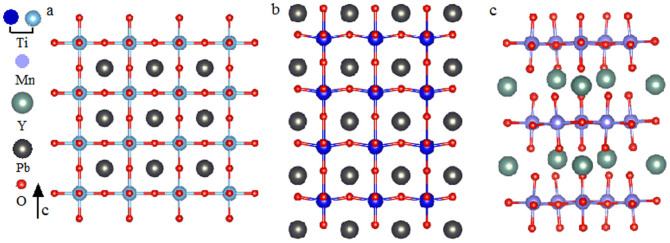
Crystal structures of ABO3 materials at the para-electric and ferroelectric phases.(a) c-cut PbTiO3 at the para-electric phase. (b) c-cut PbTiO3 at the ferroelectric phase. (c) c-cut YMnO3 at the ferroelectric phase.